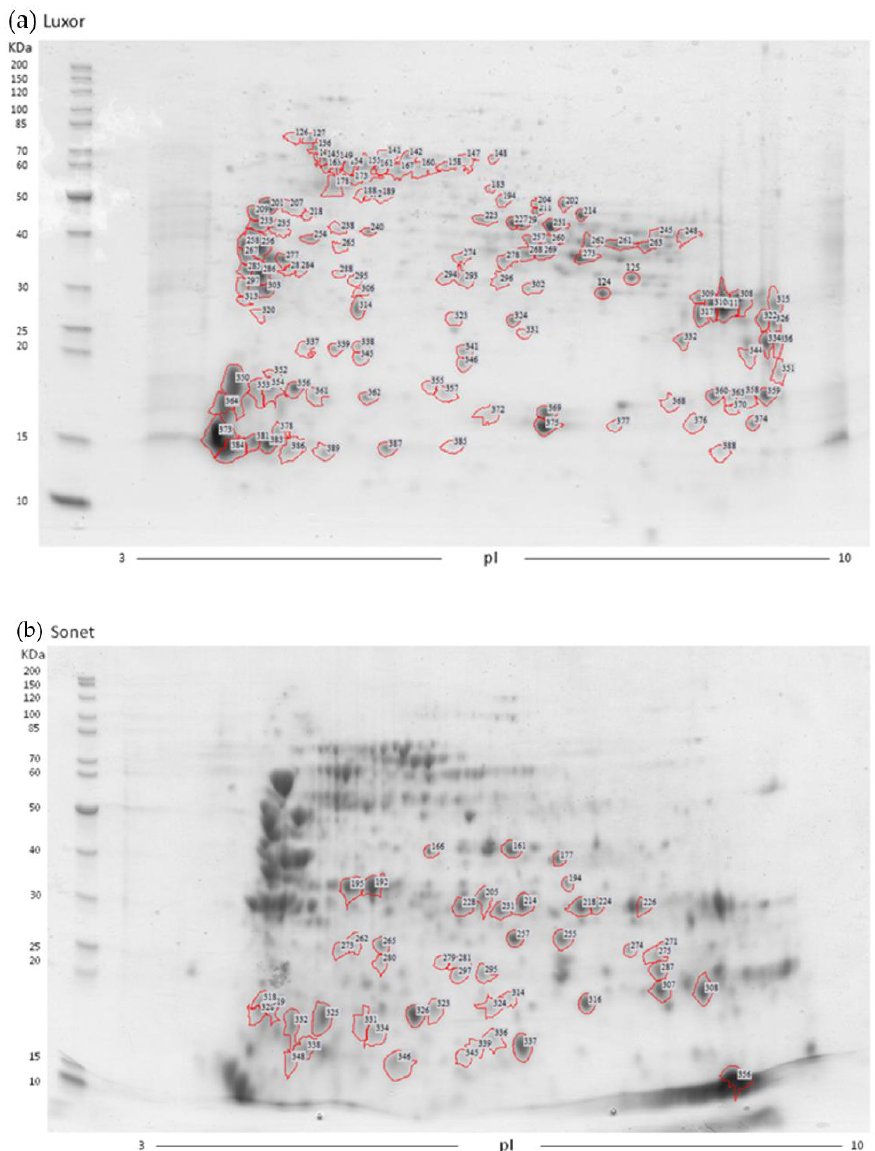
Figure 3. Excised protein spots are marked with red lines in ( a ) L. albus cv. Luxor and ( b ) L. angustifolius cv.